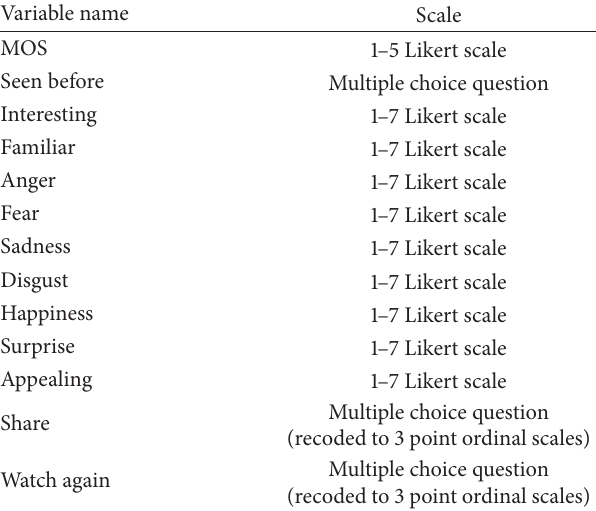
Table 2: Variables used in the